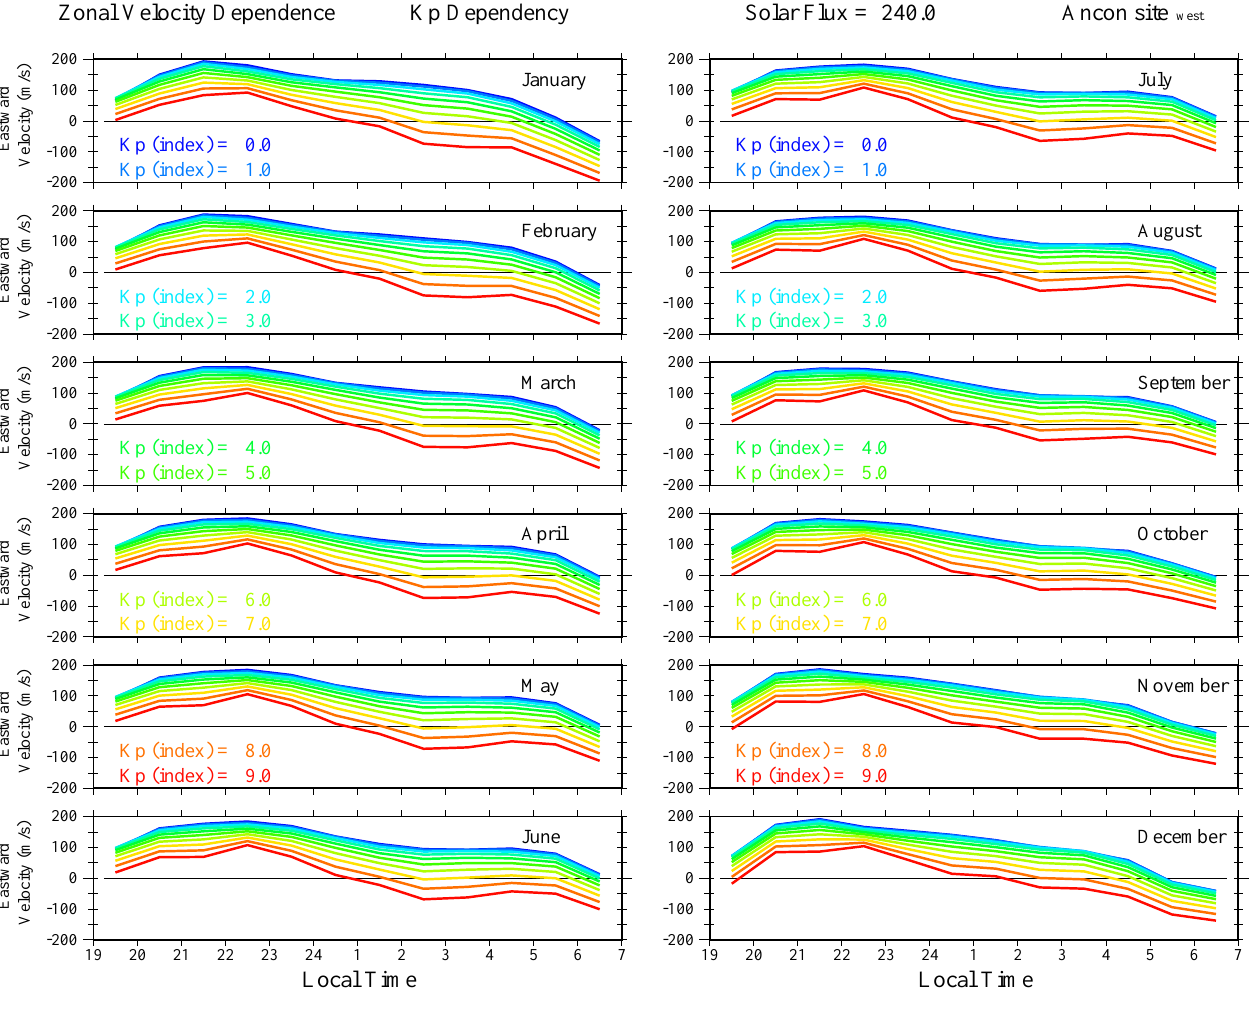
Fig. 6. (b) Ancon zonal drift dependence on K p , solar